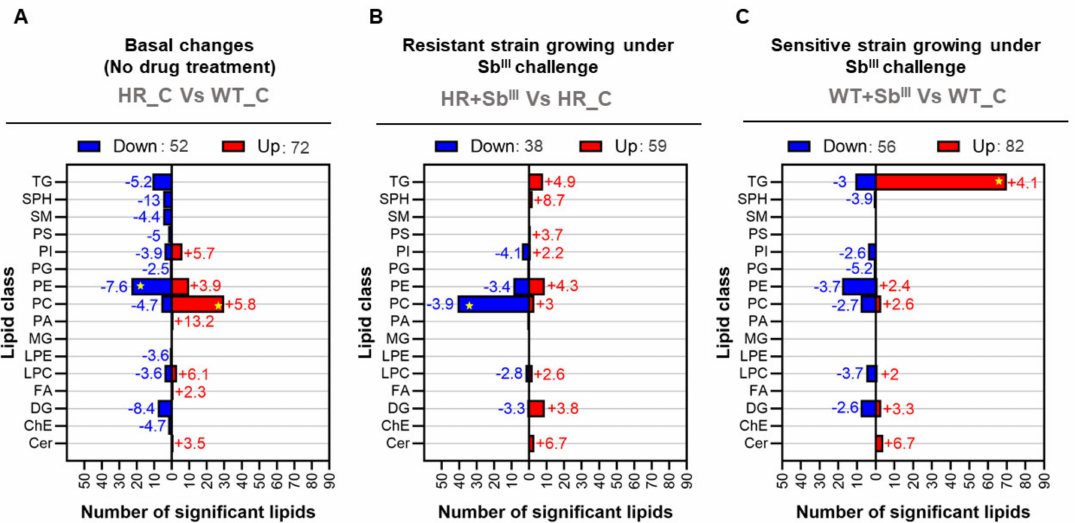
Figure 4. Phosphatidylcholines (PC) and triglycerides (TG) are the main lipid classes differentiating antimony resistant Leishmania phenotypes. All lipid classes detected are represented in the Y -axis and the number of lipids differentially expressed are represented in the X -axis. The data from three biological repeats were analyzed. The group of down regulated or up regulated lipids is highlighted in blue and red bars, respectively. The average fold changes are shown in front of each bar, and negative and positive values indicate if the lipids were detected to be decreases or increases, respectively. ( A ) Basal antimony resistant phenotype changes. ( B ) Resistant strain responding to Sb III . ( C ) Sensitive strain responding to Sb III . Duplicate signals coming from different adducts, multiple fragmentation or software lipid identification were filtered. Enriched lipid class with the highest number of differentially expressed lipids are highlighted with yellow